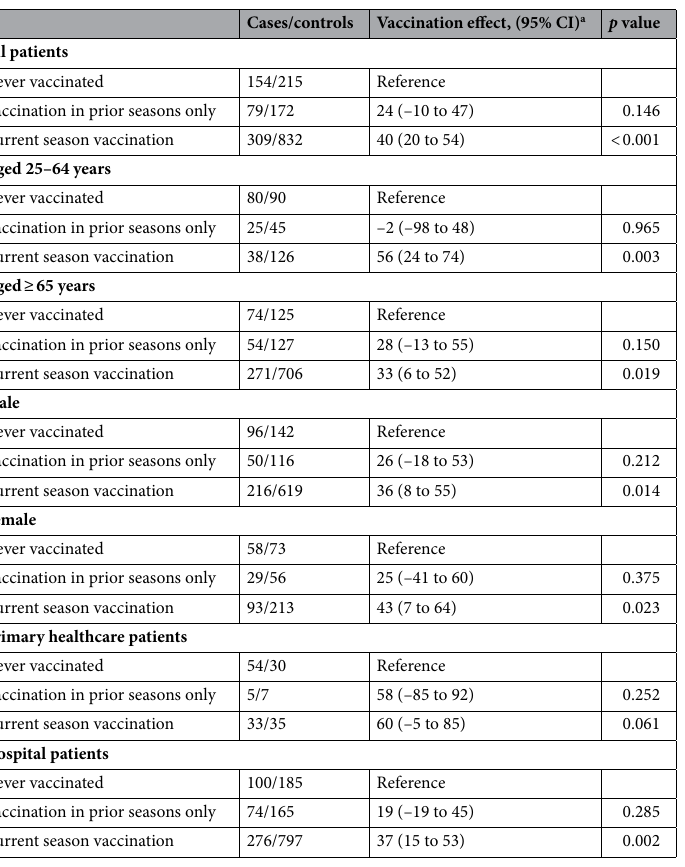
Table 2. Effect of influenza vaccination status in the current and 5 prior seasons in preventing laboratory- confirmed influenza among patients with chronic obstructive pulmonary disease. CI confidence interval. a Vaccination effect adjusted by age groups (25–64, 65–84 and ≥ 85 years), other major chronic conditions, healthcare setting (primary healthcare or hospital), and month-season of sample